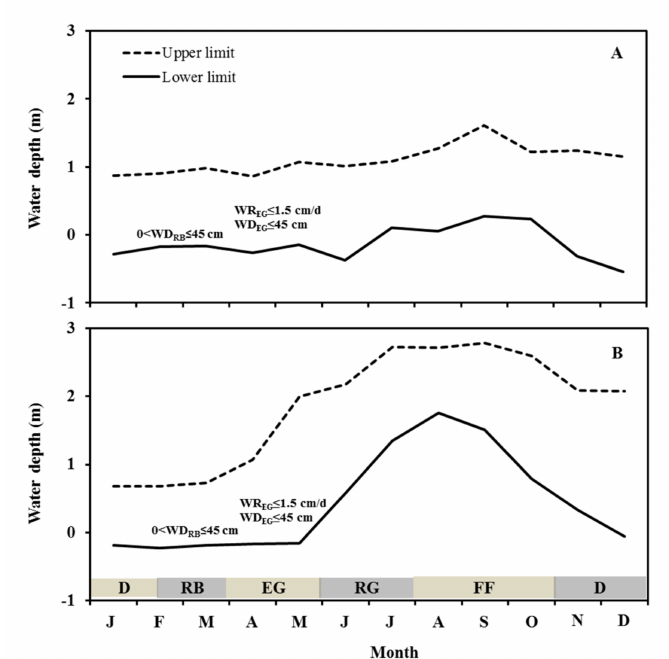
Figure 8. Conceptual model of WLF tolerances and requirements of Typha angustifolia in ( A ) lakes with reservoir-like fluctuations; ( B ) lakes with intermittent fluctuations and quasi-natural fluctuations. D indicates the dormant period; RB indicates the rhizome bud period; EG indicates the early growth period; RG indicates the rapid growth period; FF indicates the flowering and fruiting period; WD RB indicates the optimum water depth during the rhizome bud period; WR EG indicates the optimum water depth during the early growth period; WR EG indicates the optimum water rise rate during the early growth period.